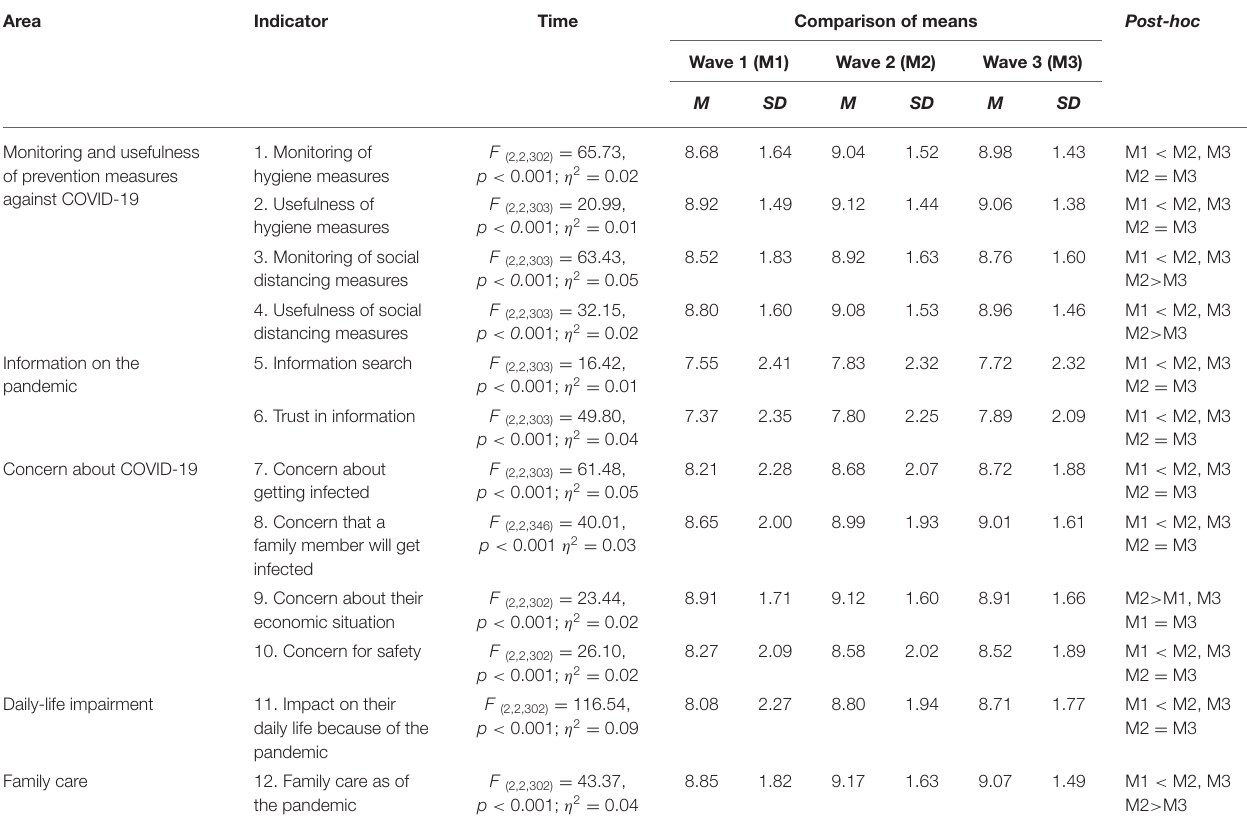
TABLE 2 | Comparisons of means of the indicators on concerns and behaviors related to the COVID-19 pandemic by wave. Area Indicator Time Comparison of means